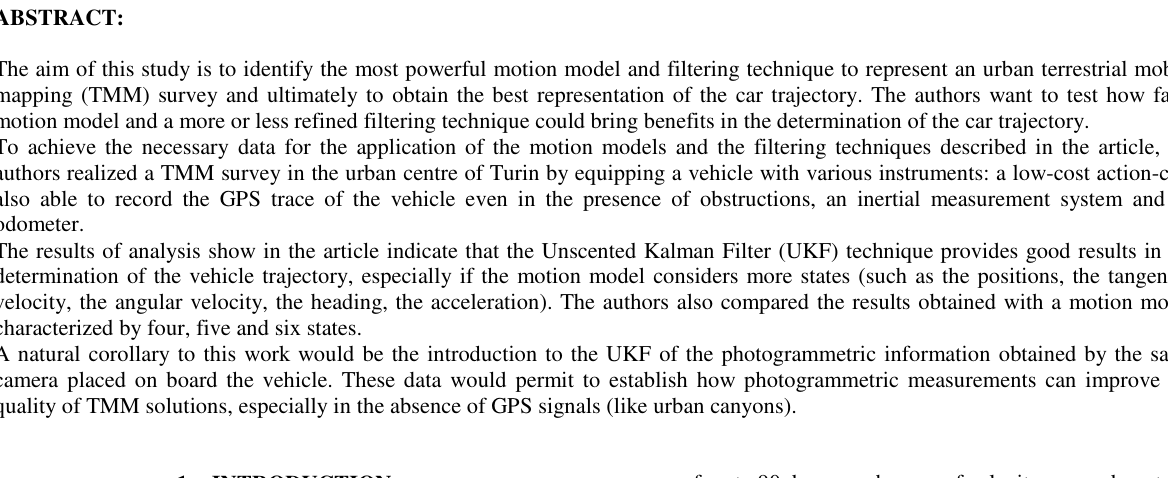
curves of up to 90 degrees, changes of velocity, some departures and stops and urban canyons, as shown in Figure 1.